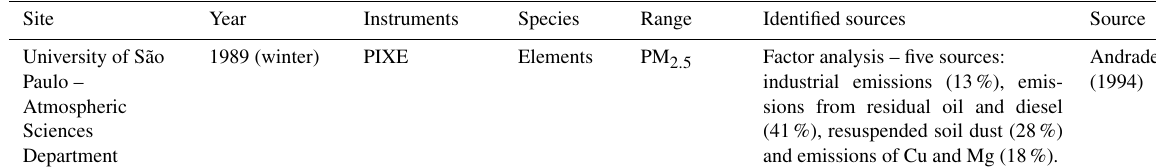
Table 1. Results of previous source apportionment studies in São Paulo